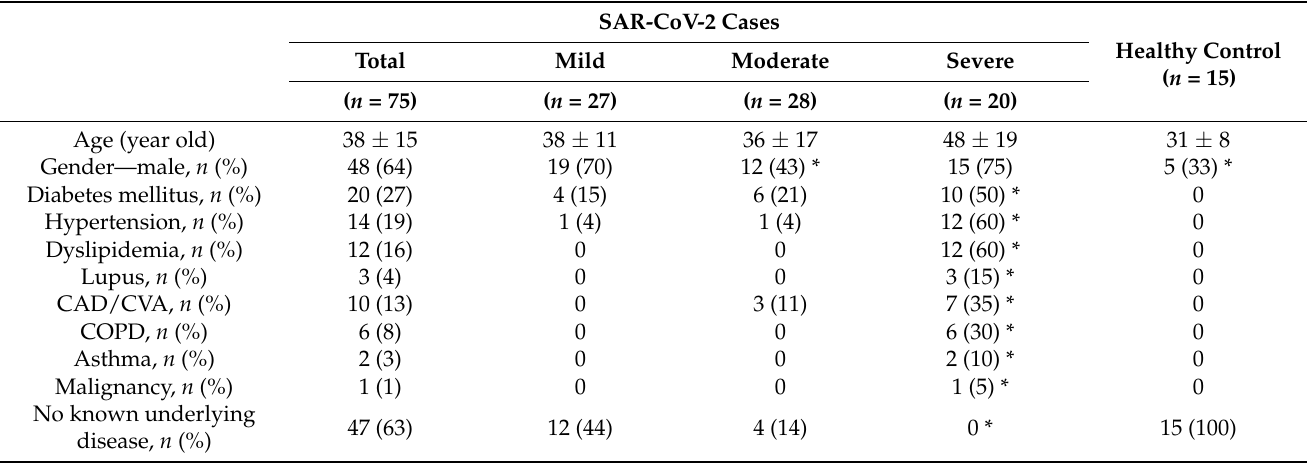
Table 1. The epidemiological data.